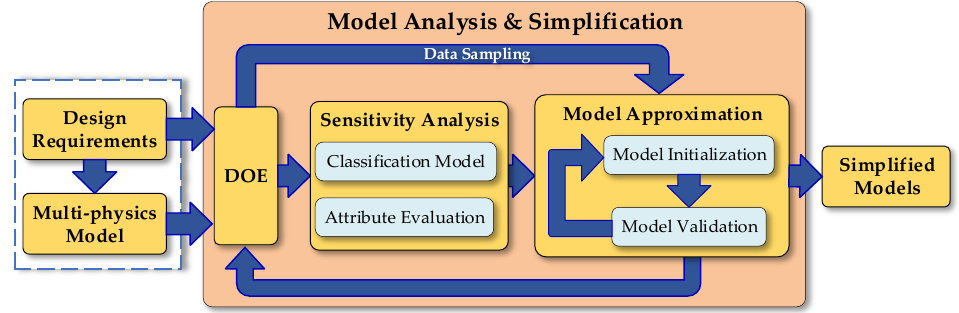
Figure 3. Figure 3. Multi-disciplinary design optimization (MDO)-based simplification of the multi-physics model.